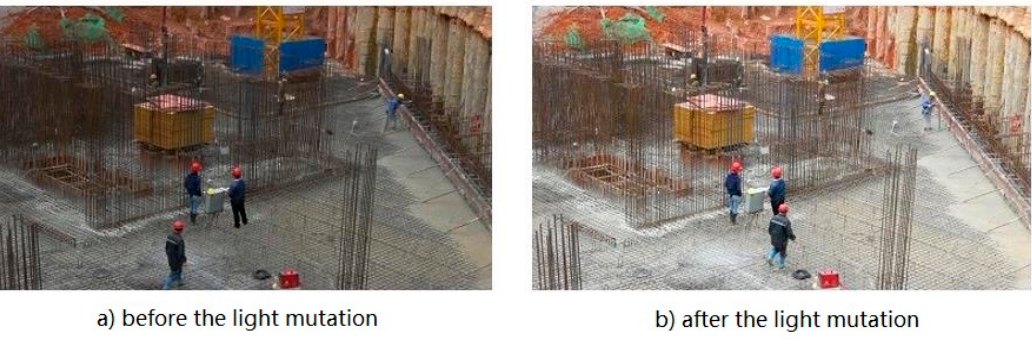
Figure 2. Light changes suddenly.